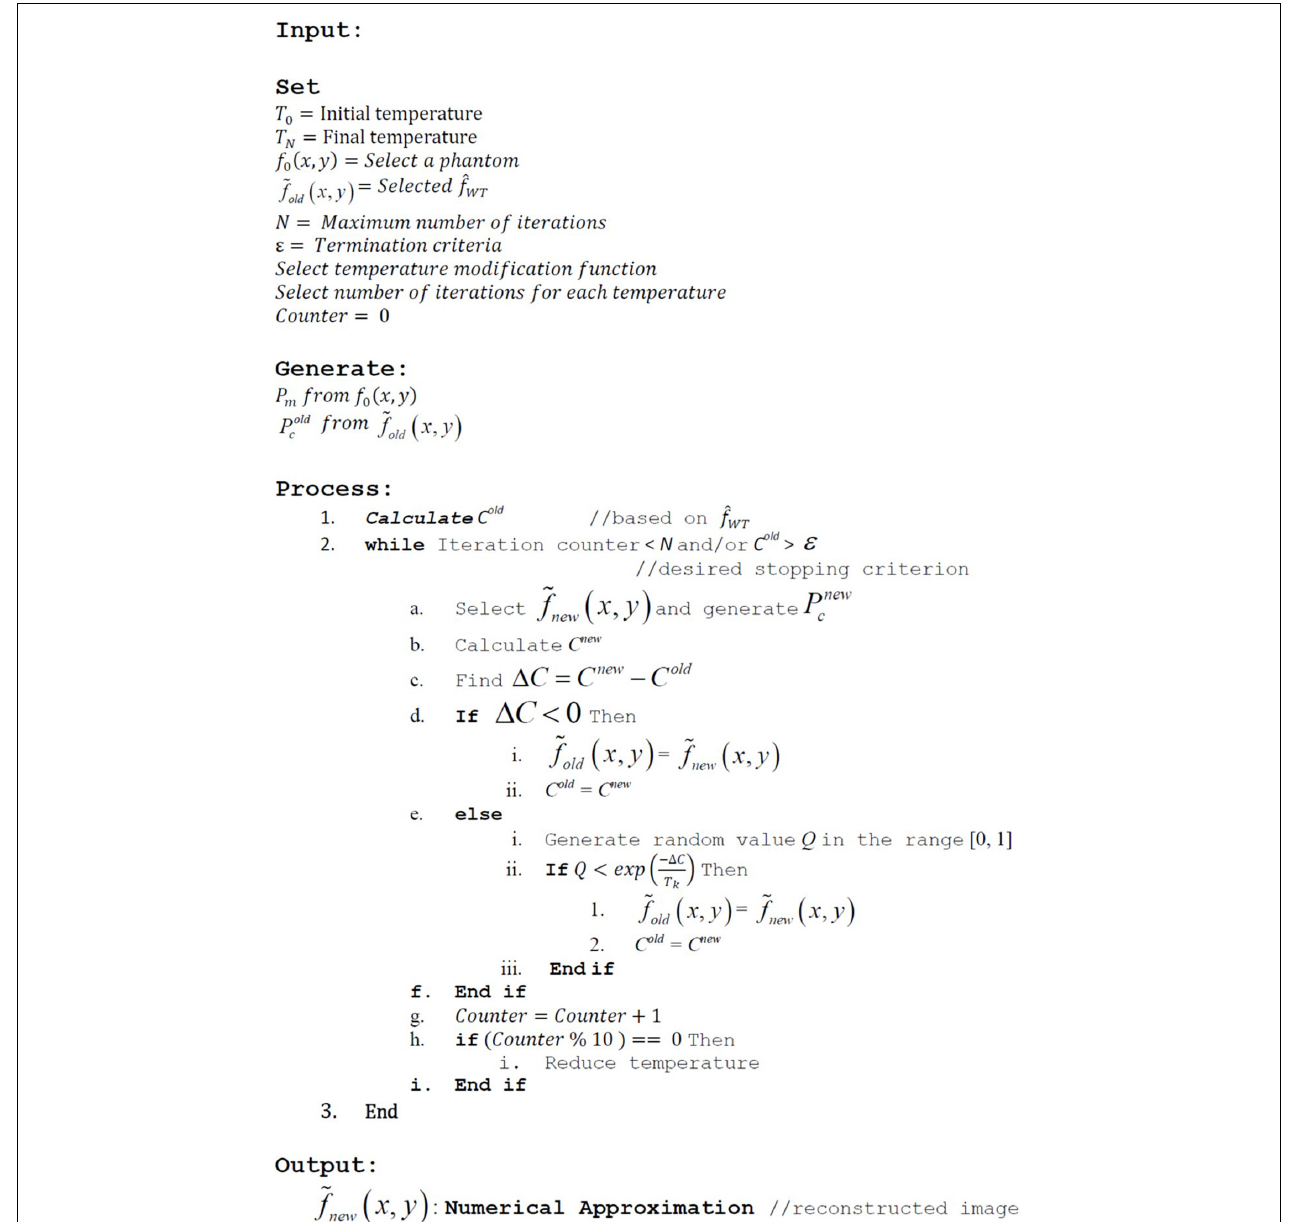
FIGURE 3 | Pseudocode for the image reconstruction algorithm.